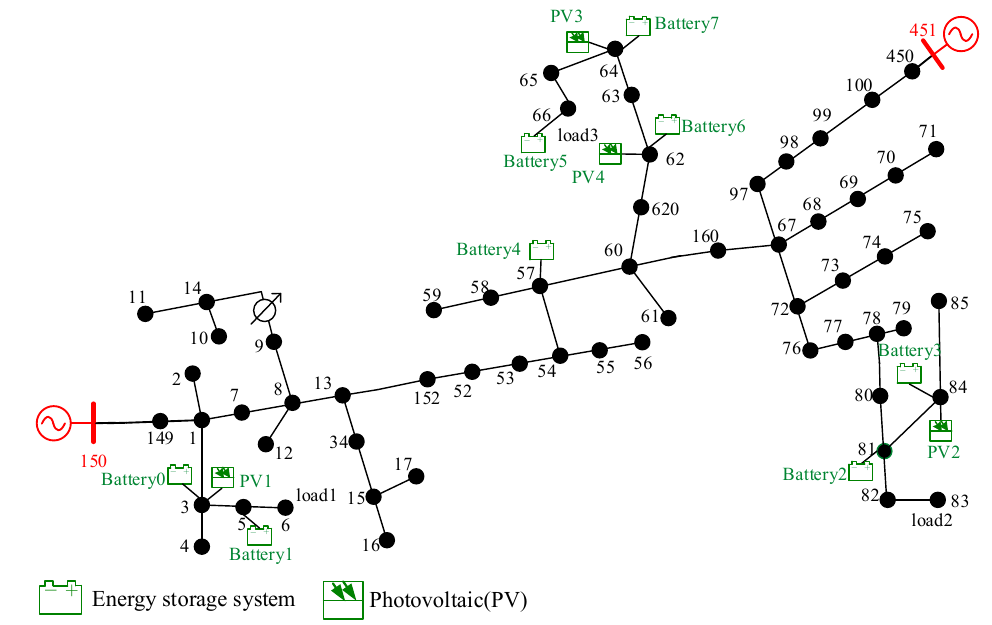
Figure 5. A low-voltage case study distribution system.